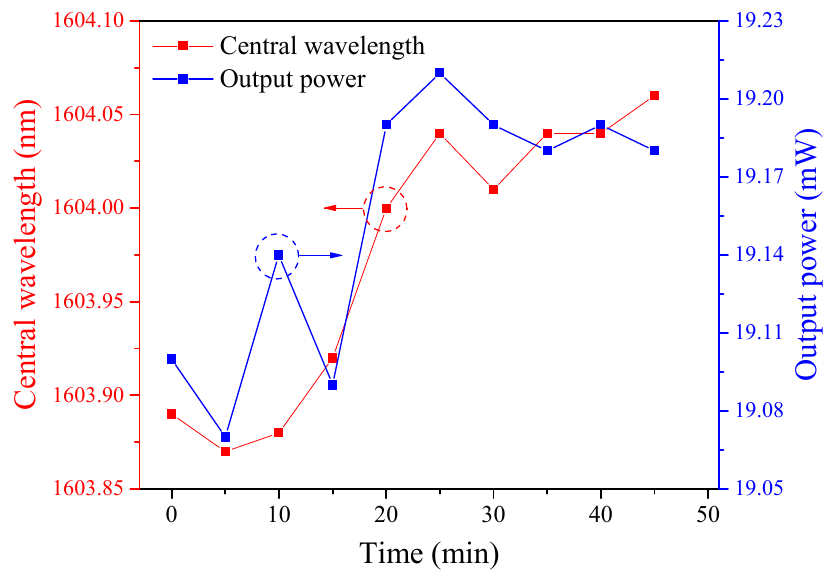
Figure 10. Stability measurements of central wavelength and output power for 45 min when the length of PMF is 5.51 m.